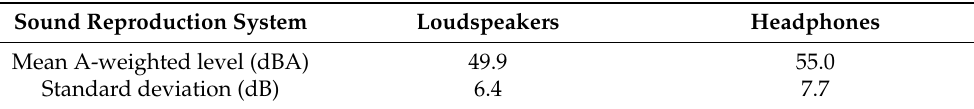
Table 4. Marginal means and standard deviations of the groups at two different levels of the sound reproduction system in the listening part of the experiment.